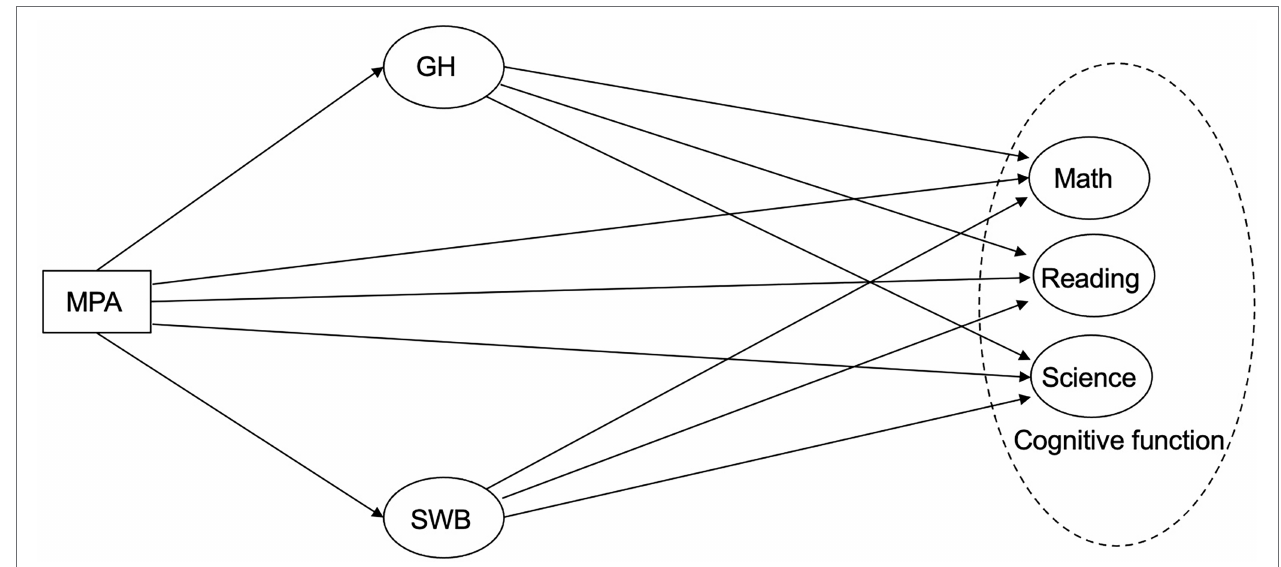
FIGURE 1 | Conceptual diagram.